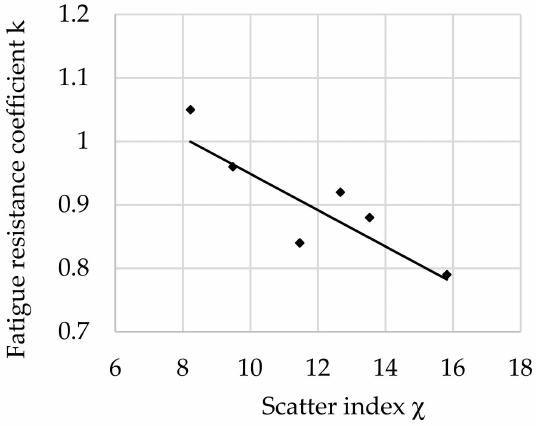
Figure 8. The relationship between the fatigue resistance coefficient and scatter index of structural steel hardened and tempered at 600 ◦